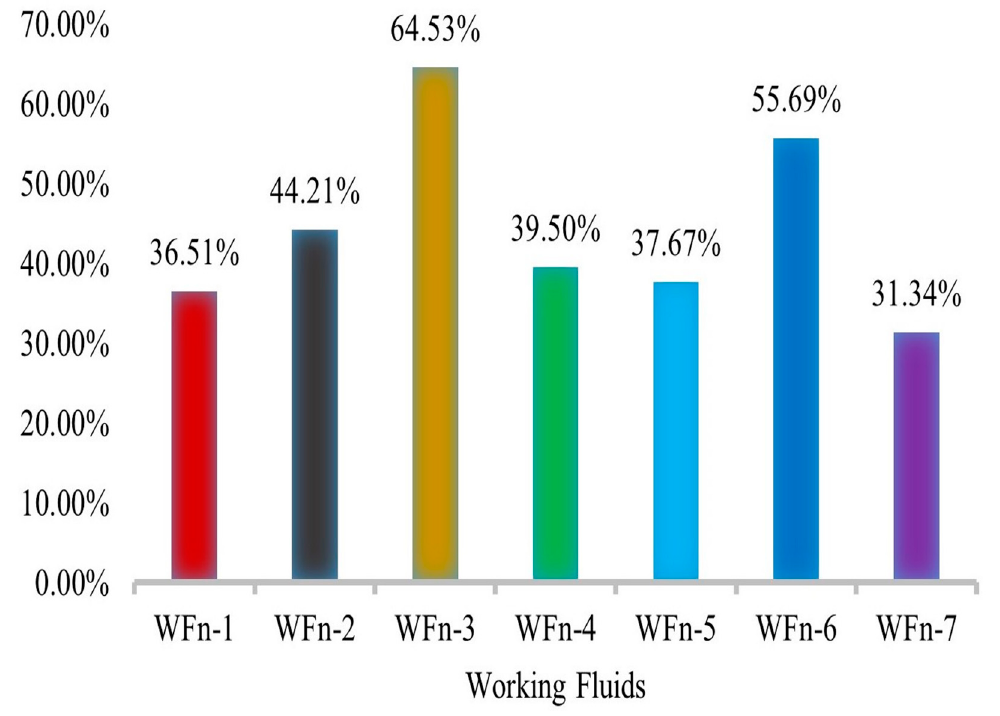
Figure 9. Demonstration on the obtained exergy efficiency percentage using working fluid in multiple